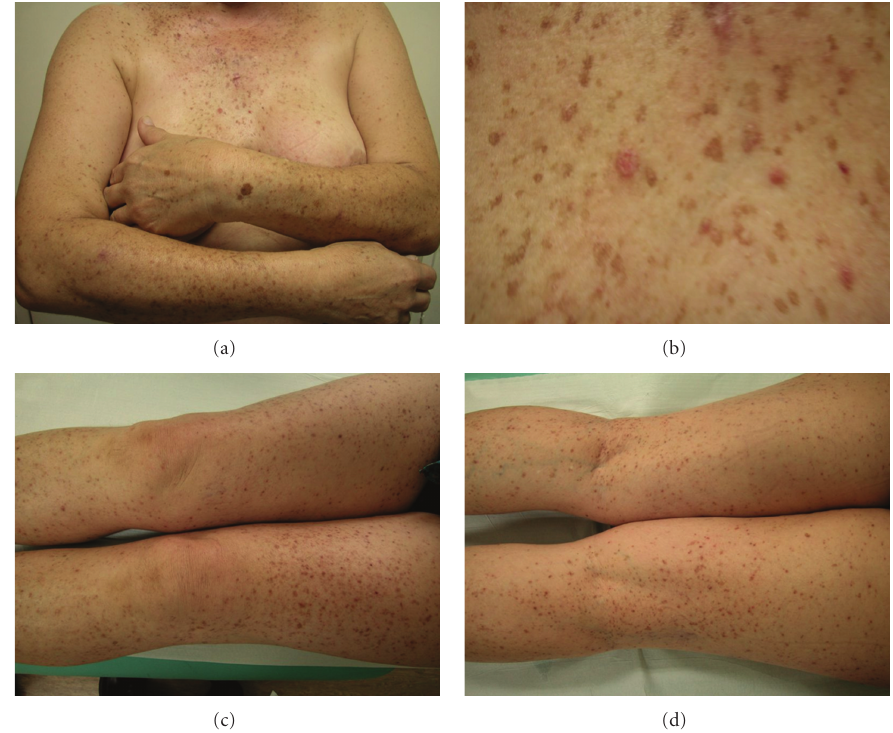
Figure 1: Polymorphous dermatosis characterized by disseminated erythematous papules and plaques and multiple brown macules.